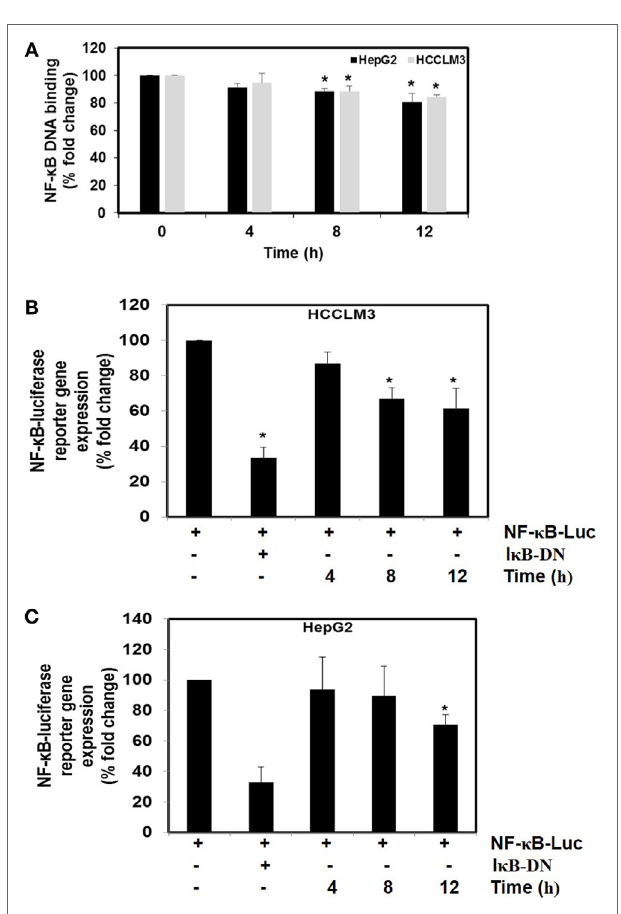
FigUre 3 | (a,B) CMO inhibits the phosphorylation of I κ B and depletes the nuclear pool of p65 in hepatocellular carcinoma cells. HepG2 cells were treated with 25 µM CMO for indicated time point, after which, the cytoplasmic and nuclear extracts were prepared, and protein was resolved on SDS-PAGE gel, electrotransferred onto nitrocellulose membranes, and probed for phospho- I κ B, I κ B, phospho-p65, p65, GAPDH, and Lamin B antibodies.